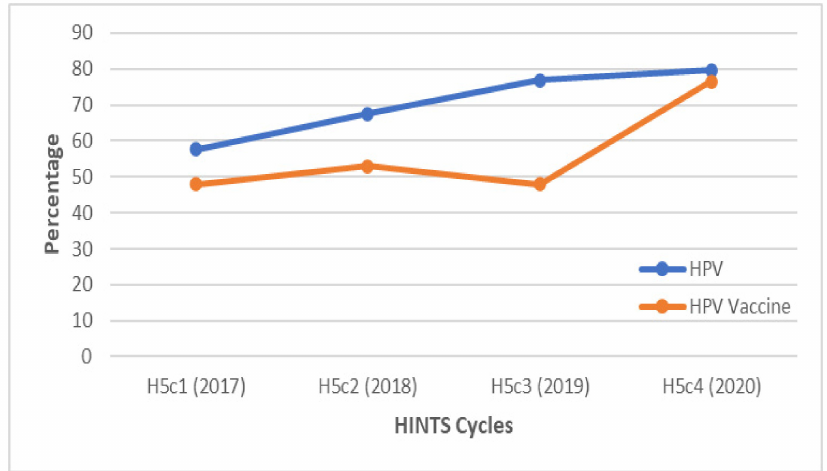
Figure 1. Overall awareness of HPV and the HPV vaccine among gay and bisexual males between 2017 and 2020. The awareness of HPV was consistently greater than the awareness of the HPV vaccine. Overall, the awareness of both was higher in 2020 compared to